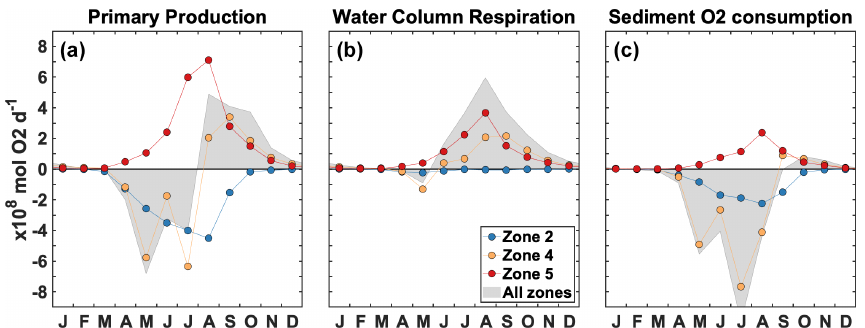
Figure 7. Spatially integrated change due to P limitation for primary production (a) , water column respiration (b) , and sediment O 2 con- sumption (c) in zone 2 (blue), zone 4 (orange), zone 5 (red), and zones 1–6 combined (shaded area). Each dot represents a monthly mean for 2008–2013.